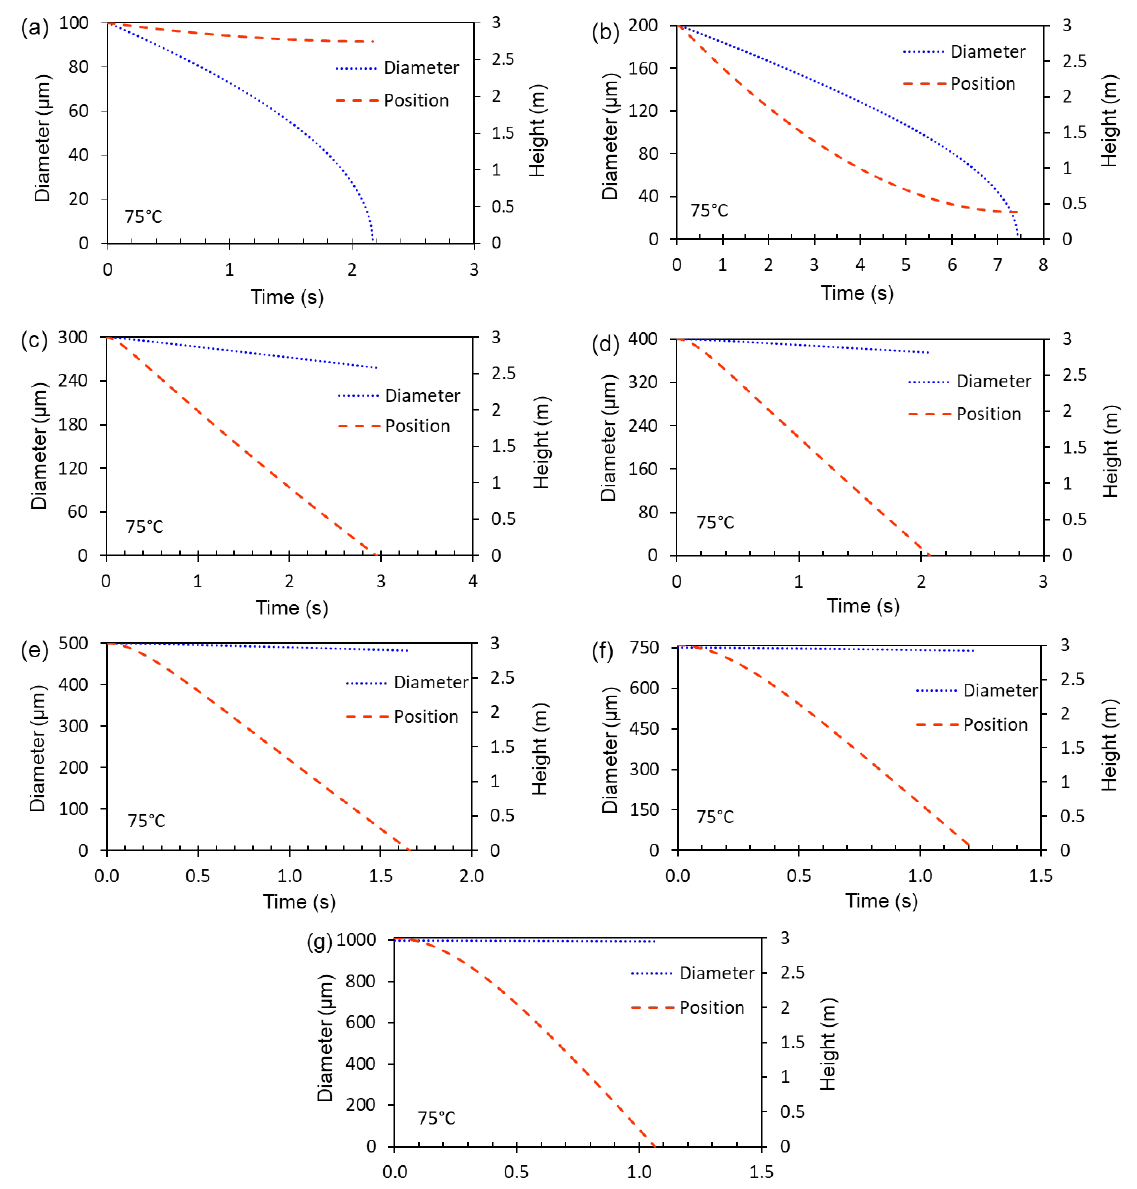
Figure 4. Diameter and position history of droplets with different initial diameters at condition 1 (75 °C); ( a ) 100 µm; ( b ) 200 µm; ( c ) 300 µm; ( d ) 400 µm; ( e ) 500 µm; ( f ) 750 µm; and ( g ) 1000 µm.